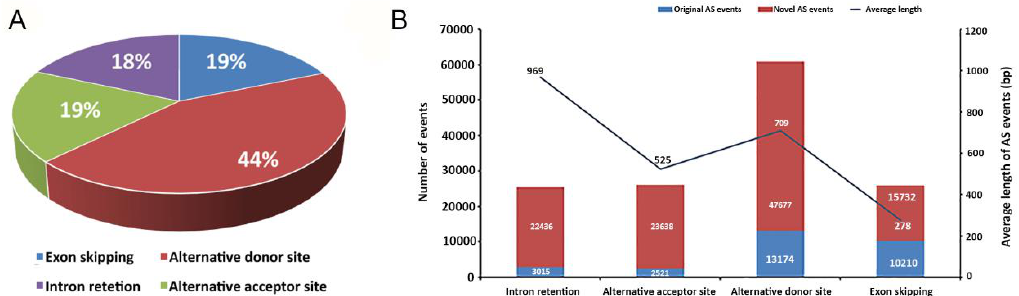
Figure 1. Four modes of alternative splicing (AS). ( A ) The proportion of exon skipping, alternative donor sites, alternative acceptor sites, and intron retention. ( B ) Left y -axis: the number of known (blue bars) and novel (red bars) alternative splicing events. Right y -axis: average length of alternative splicing events (black polyline).